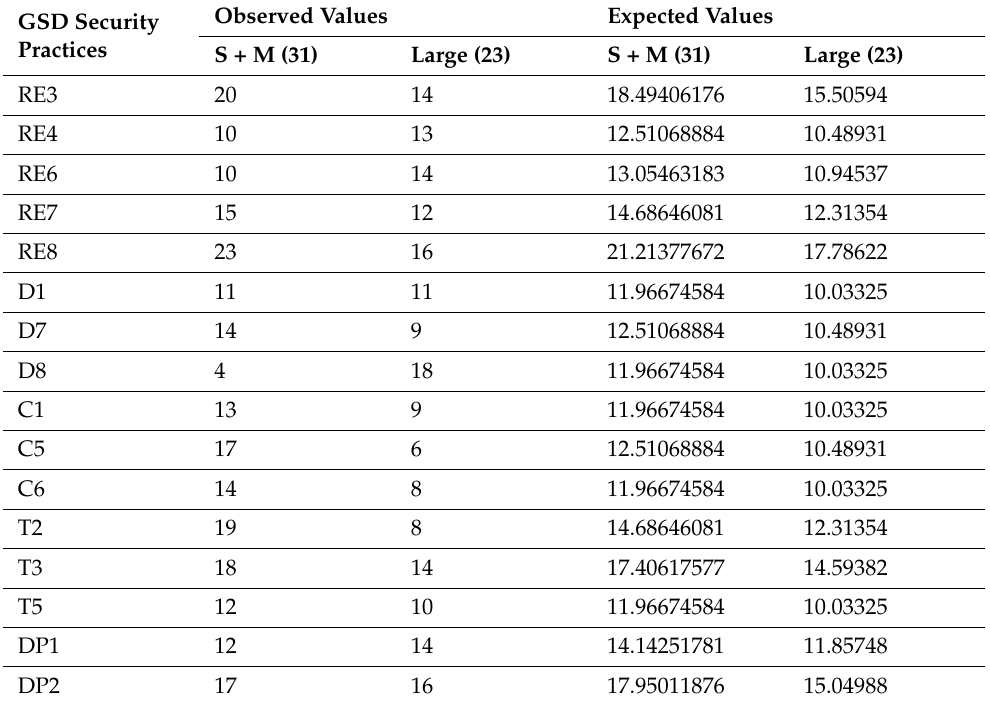
Table 5. Observed and expected values of selected GSD security practices by combining. Column 1 and column 2 of expected and observed